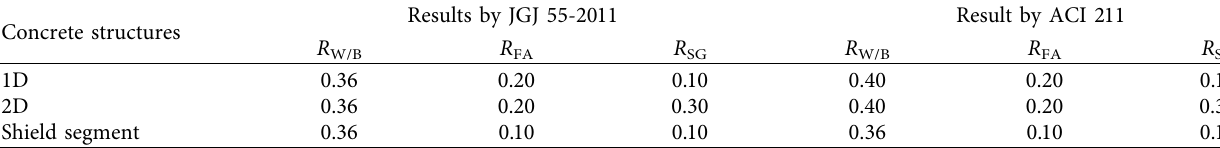
Table 9: Comparison of calculation for JGJ 55-2011 and ACI 211.